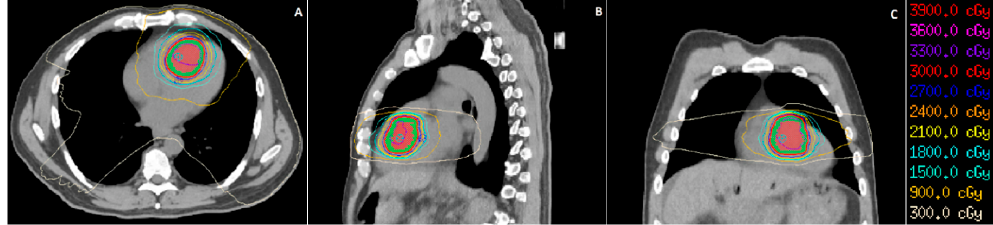
Table 1. Stereotactic body radiation therapy (SBRT) treatment planning dose statistics. Region of